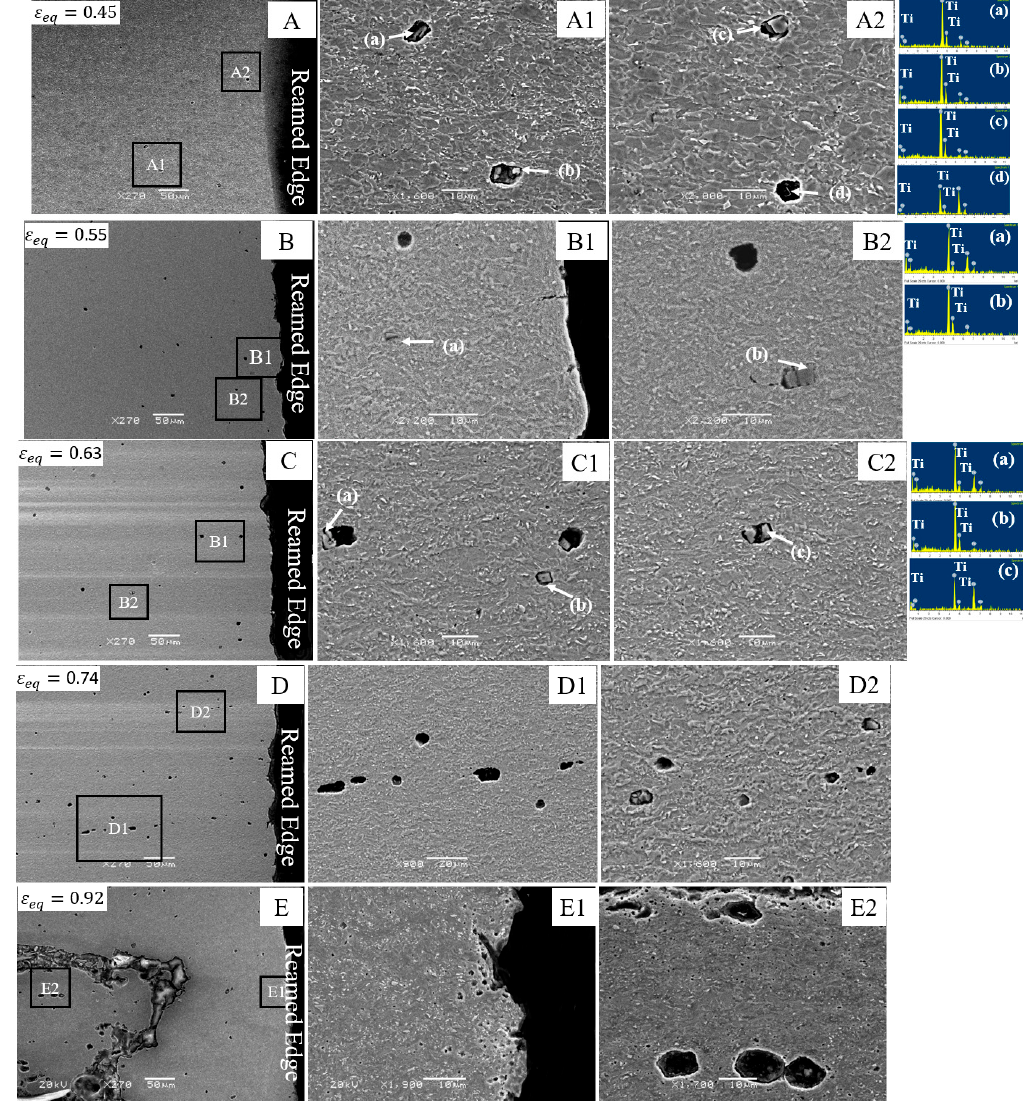
Figure 13. SEM micrographs of the interrupted CP800 reamed edge hole tension specimens at different strain levels: ( A ) 0.45; ( B ) 0.55; ( C ) 0.63; ( D ) 0.74; and ( E ) 0.92. strain levels: ( A ) 0.45; ( B ) 0.55; ( C ) 0.63; ( D ) 0.74; and ( E )